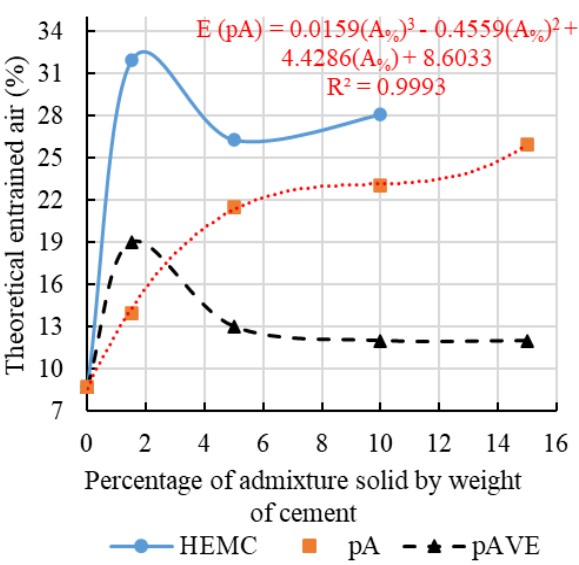
Figure 7. Theoretical entrained air